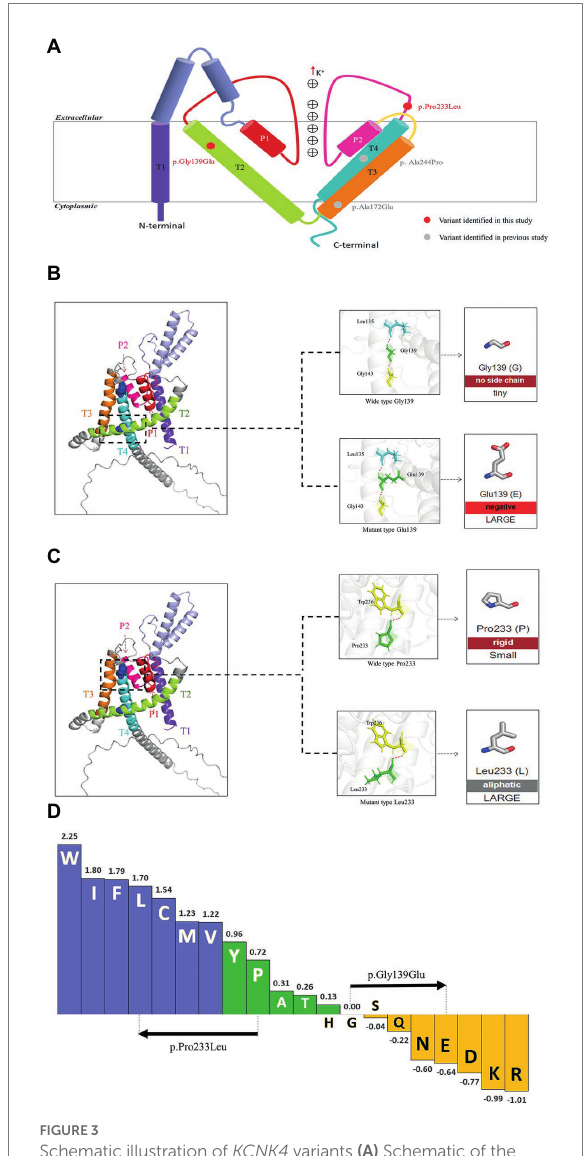
FIGURE 3 Schematic illustration of KCNK4 variants (A) Schematic of the location of all KCNK4 variants. Variants identified in this study were shown in red color. Variants reported previously were shown in gray color. (B) Protein modeling of the p.Gly139Glu variants. The dashed line box in the left panel indicated the wild- type structure of K2P4.1 channels of p.Gly139Glu. The substitution of Glutamic acid in residue Gly139 was not predicted to alter hydrogen bonds but the polarity of amino acids. (C) Protein modeling of the p.Pro233Leu variants. The dashed line box in the left panel indicated the wild-type structure of K2P4.1 channels of the p.Pro233Leu. The substitution of Leucine in residue Pro233 seems not to affect the hydrogen bonds or polarity/charge. (D) Fauchère and Pliska hydrophobicity scale exhibited the hydrophobicity of 20 amino acids. Abscissa: from left to right, hydrophobicity gradually decreased. Blue amino acids were hydrophobic, green amino acids were neutral, and yellow amino acids were hydrophilic. Amino acids with high positive values are more hydrophobic, whereas amino acids with low negative values are more hydrophilic.